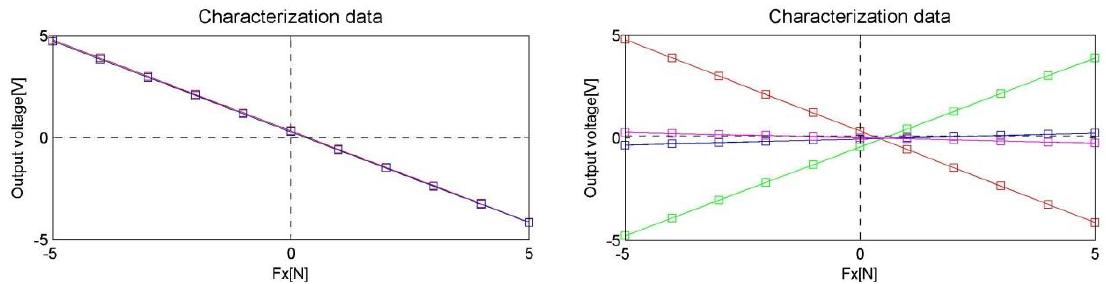
Figure 14. Plot of the measures of one of the four signals ( ) during loading (blue) and unloading cycles (red) and plot of averages between unloading and loading values for all the four signals. Force is applied along x-axis.